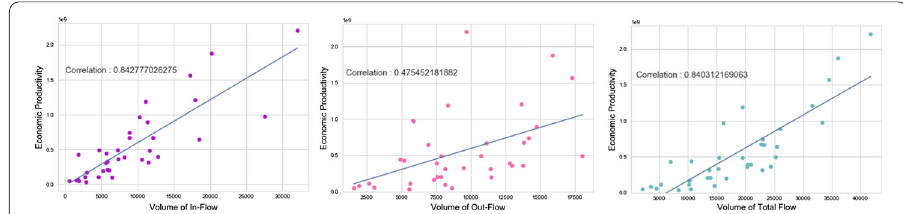
Figure 2 Scatter plot of total flow volumes (Left: Inflow, Middle: Outflow, Right: Total Flow) and the economic productivity of each district in